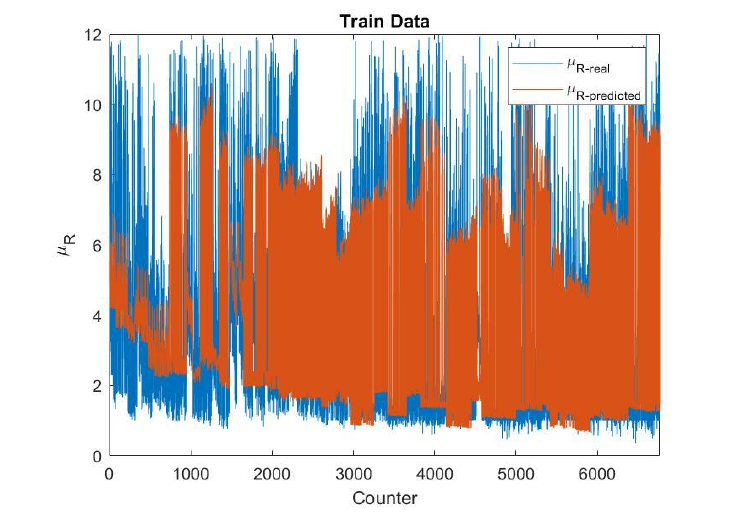
Figure 10. Comparison between the real and predicted value of ( μ R ) in training data (FCM